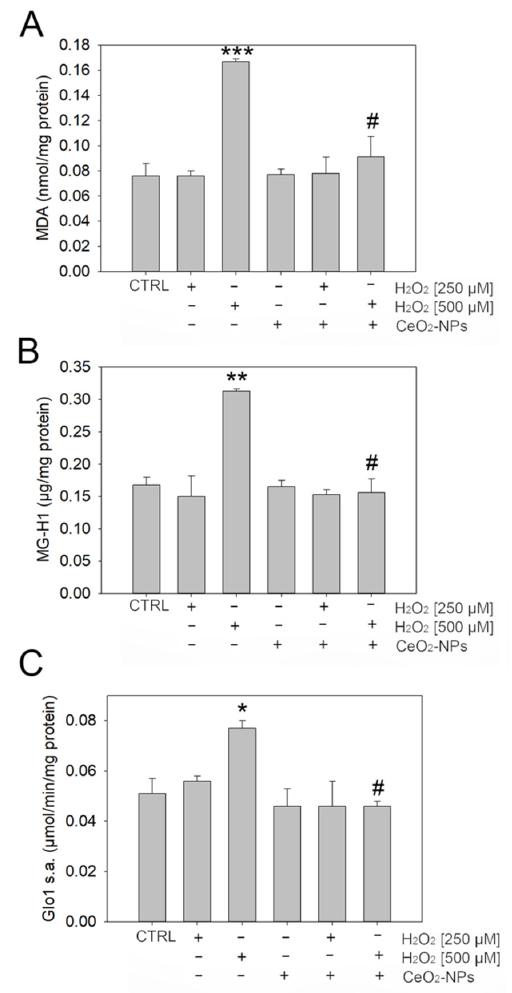
Figure 5. Effect of CeO 2 -NPs (0.1 mM) on dicarbonyl stress in ARPE-19 treated with two concen- trations of H 2 O 2 (250 and 500 µ M). ( A ) Malondialdehyde (MDA) levels; ( B ) MG-H1 levels; ( C ) Glo1 specific activity. Histograms indicate the means ±SE of three different cultures, each of which was tested in triplicate. Statistical analysis was performed by one-way ANOVA followed by Tukey’s test * p < 0.05 and ** p < 0.01, *** p < 0.001 vs. control. # p < 0.05 vs. H 2 O 2 .